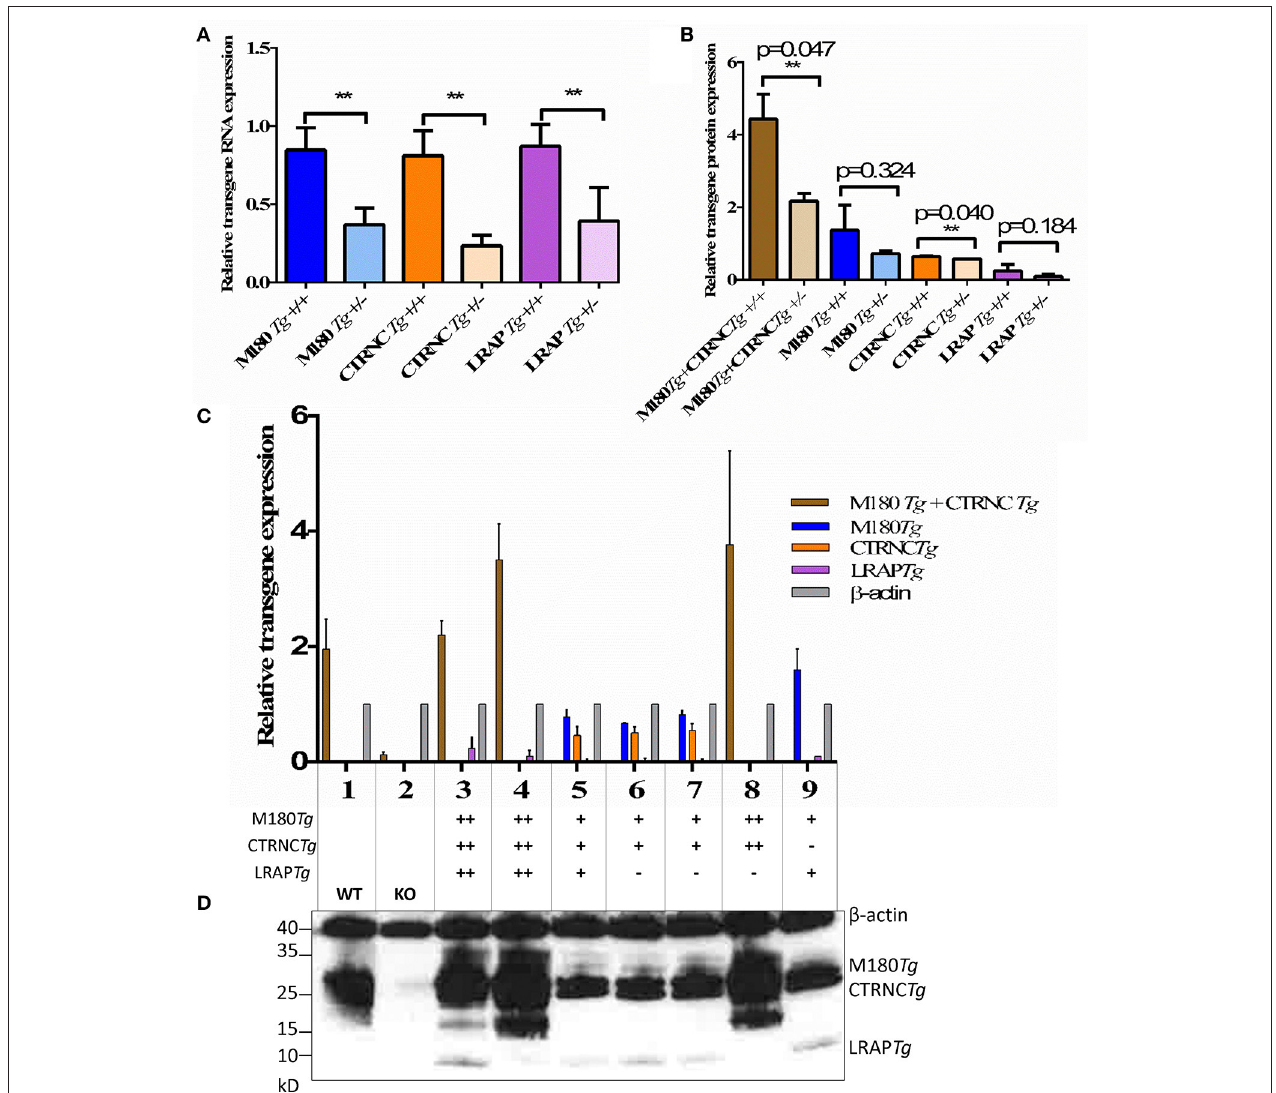
FIGURE 1 | Relative amelogenin transgene DNA and protein expression in double and triple transgenic/ Amelx KO mice. (A) Relative transgene copy number of homozygous vs. hemizygous M180 Tg , CTRNC Tg , and LRAP Tg as determined by qPCR analyses with transgene-specific probes designed and tested by Transnetyx (Cordova, TN) (**indicates significant difference, p < 0.0001). (B–D) Western blot of Amelx protein expression using anti-Amelogenin FL-191 (Santa Cruz), with β -actin control (Sigma) in transgenic 5 day-old developing molars. (B) Relative transgene protein expression of homozygous vs. hemizygous M180 Tg , CTRNC Tg , and LRAP Tg as determined by Western blot analyses as measured by ImageJ using β -actin to normalize. Since we could not differentiate between M180 Tg and CTRNC Tg in lanes 1, 3, 4, and 8, M180 Tg and CTRNC Tg expression intensities were pooled when quantifying. Due to the lack of Mmp20 in lanes 5, 6, and 7, we were able to differentiate between M180Tg and CTRNC Tg . ( n = 3 blots, **indicates significant difference, p < 0.005). (C) Relative transgene protein expression for different genotypes as determined by Western blot analyses as measured by ImageJ using β -actin to normalize. Lane 1, WT; Lane 2, Amelx KO; Lane